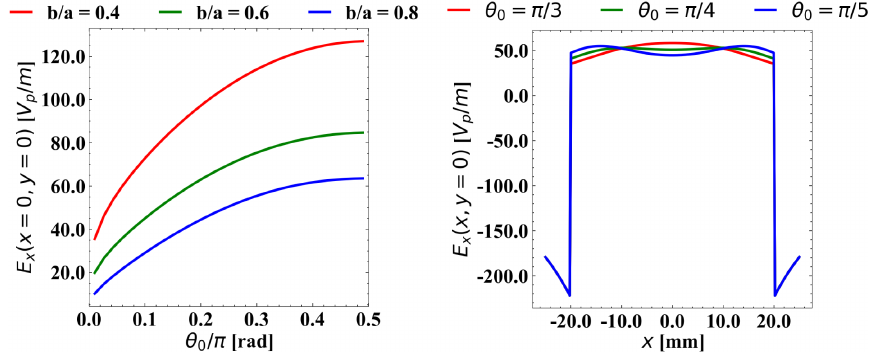
0 ; 0 Þ at the center of the beam pipe as a function of θ FIG. 5. Left: Horizontal electric field E x ð x; 0 Þ along the x axis between the plates at x ¼ (cid:1) 20 mm with a ¼ 25 mm for different values of θ 0 Horizontal electric field E x ð